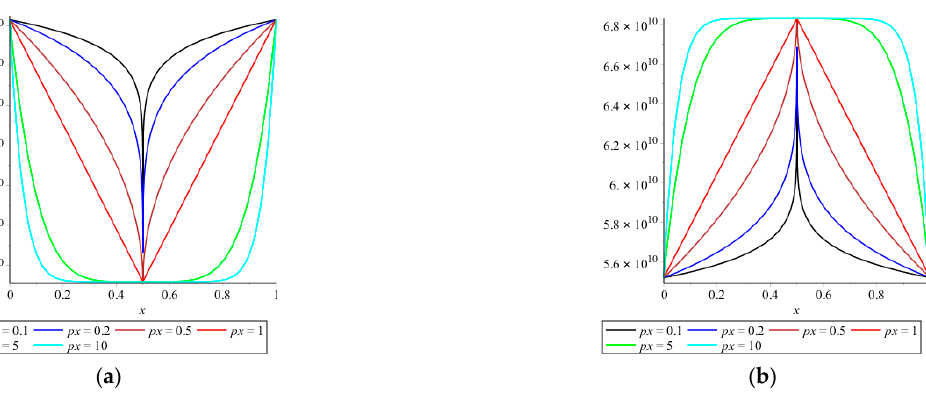
Figure A3. Young’s modulus evolution [Pa] of ( a ) FGM1-X; ( b ) FGM2-X.